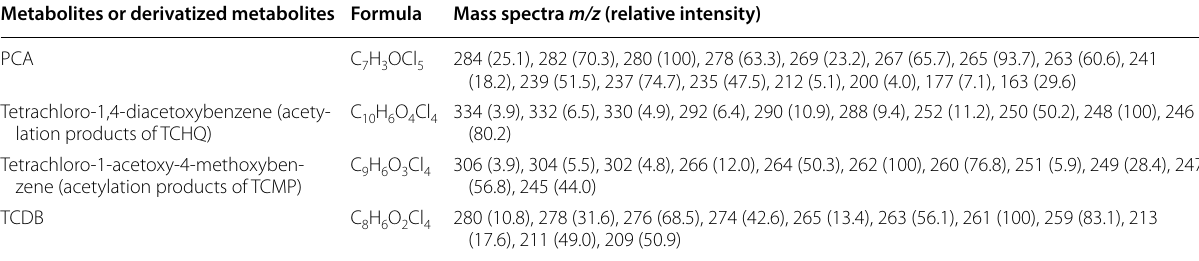
Table 2 Mass spectra of the metabolites of PCP from culture of P. acanthocystis Metabolites or derivatized metabolites Formula Mass spectra m/z (relative